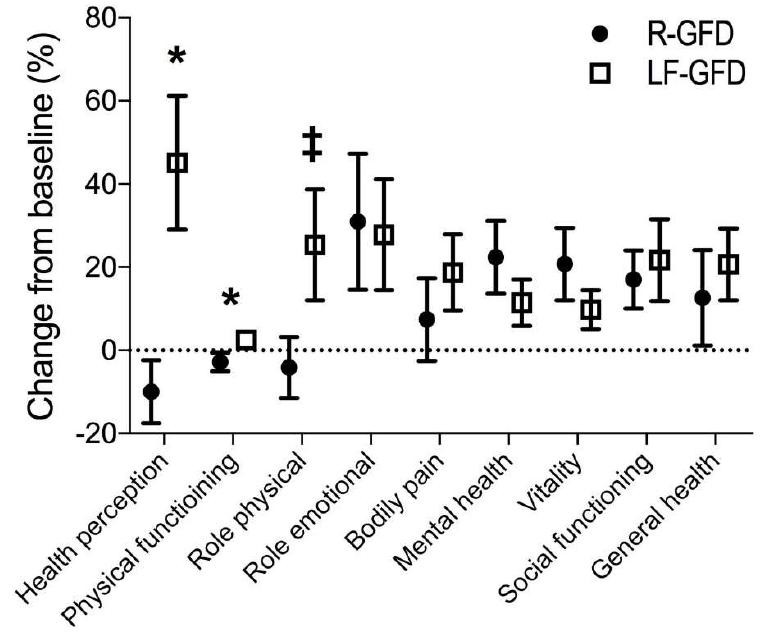
Figure 1. Change in the SF-36 questionnaire scores between the baseline and day 21 from intervention. Data shown as mean (symbol) ± SEM (upper and lower whiskers). For each sub-item, the difference between the values after intervention and the baseline was calculated and divided by the respective baseline value, expressed as a percentage, * p < 0.05; ‡ p = 0.06, for comparison between groups for each sub-item. R-GFD: regular gluten-free diet; and LF-GFD: low-FODMAP gluten-free diet.